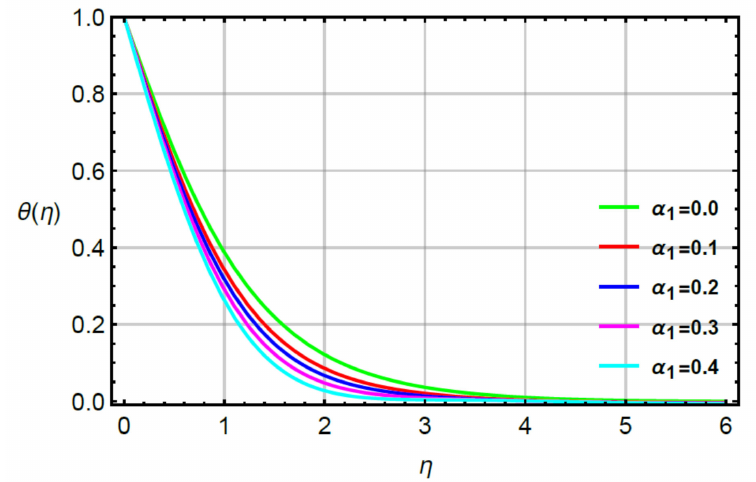
Figure 10. Behavior of θ ( η ) for α 1 when R = 0.1, Sc = 0.6, α 2 = 0.2, γ 2 = 0.3, M = 0.1, δ =